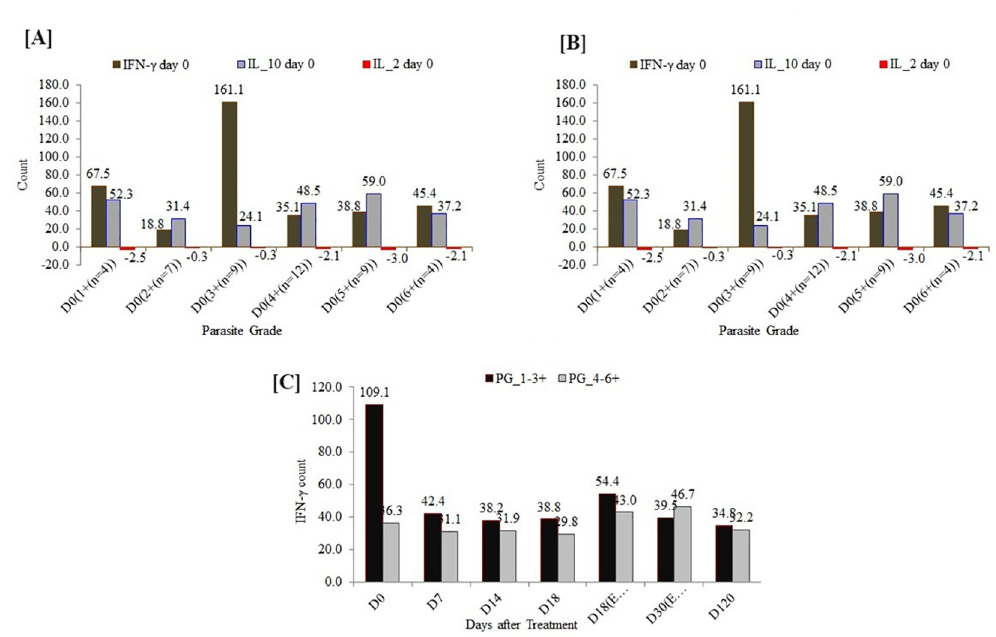
Fig 5. Comparison of the baseline parasite grade (PG) and serum cytokine